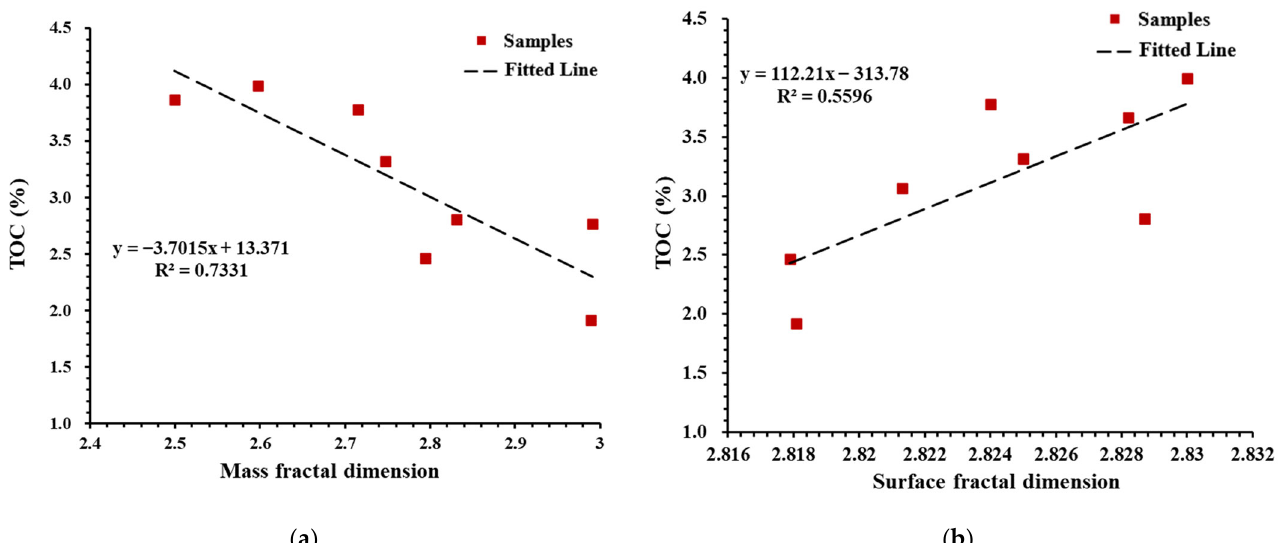
Figure 5. Relationship between the fractal dimension and TOC: ( a ) mass fractal dimension and ( b ) surface fractal dimension.